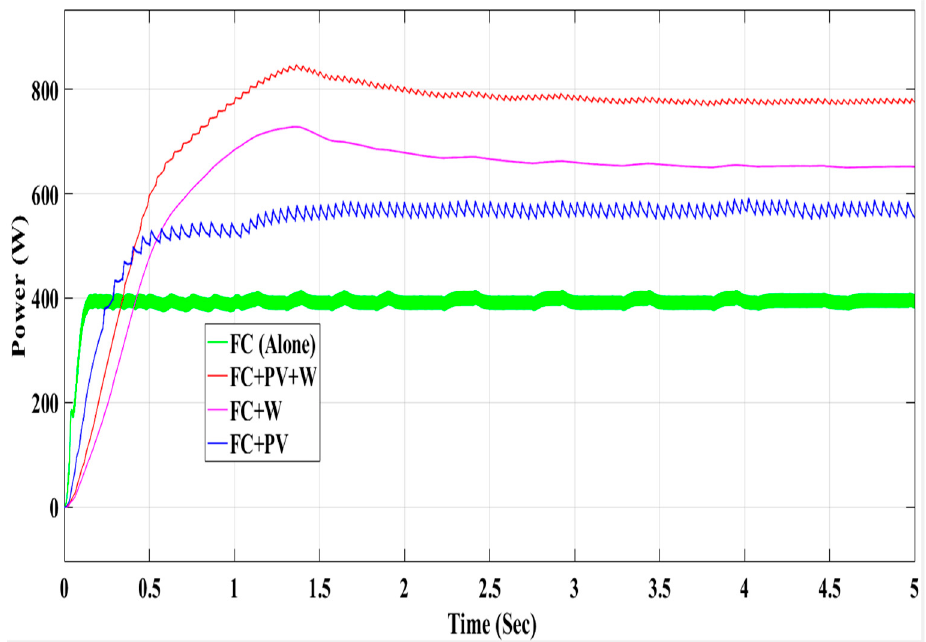
Figure 31. Comparative characteristics of power in the FC, FC–PV, FC–W, and FC–PV–W models using the P&O controller.